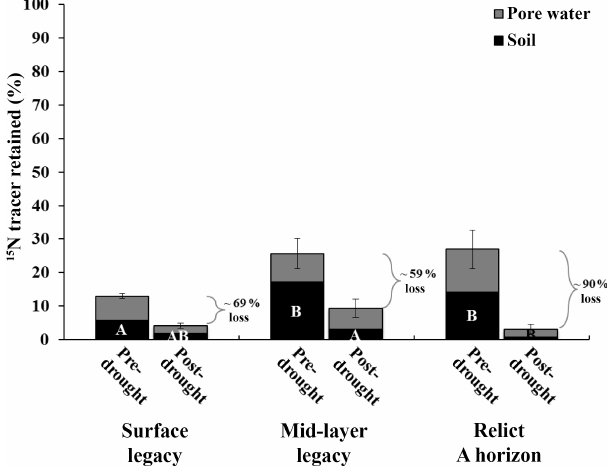
− ) (%) retained in the Figure 4. Amount of tracer 15 N (as 15 NO 3 soil (black bars) and pore water (gray bars) pools pre-drought and post-drought. Vertical bars denote 1 standard error of the mean for the two pools combined ( n = 5). Retention of 15 N was not found to be statistically significant among soil horizons when the two pools were combined. However, for a given pool and sampling time different letters represent statistically significant ( P< 0 . 05) differ- ences across soil horizons. The average pulsed loss of 15 N (%) from each soil horizon signifies the percent decrease in 15 N reten- tion (soil + pore water pools combined) between the two moisture conditions (pre-drought and